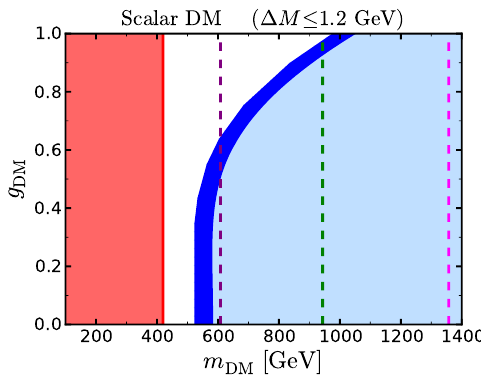
Figure 11 . Model 2: plot of the coupling g versus the dark matter mass m DM = m S . We scan DM over (cid:1) M [0 ; 1 : 2 GeV], where (cid:1) M = M (cid:9) m S . The dark blue band satis(cid:12)es the correct DM relic 2 (cid:0) abundance within 3 (cid:27) , the region in light blue overproduces the amount of DM. The colour-coding for the exclusion regions is the same as in the previous